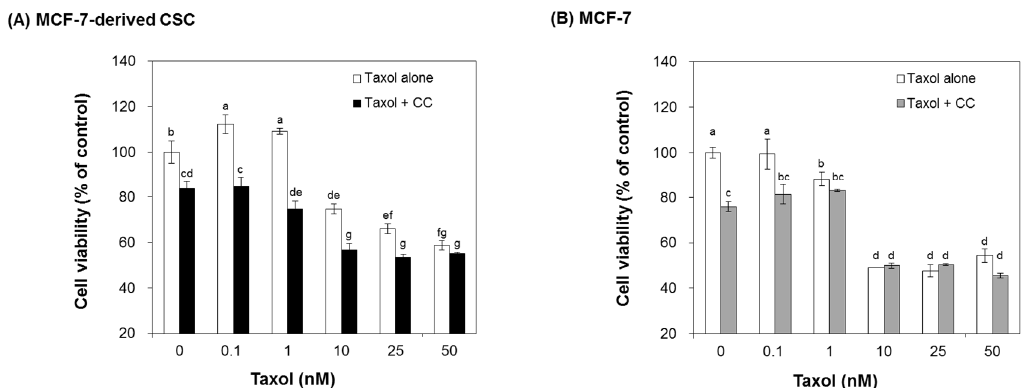
Figure 5. Chestnut leaf extract-treated CSCs were more susceptible to Taxol treatment than untreated CSCs. Both MCF-7-derived CSCs ( A ) and their parental cells ( B ) were treated with chestnut leaf extract in the presence of Taxol at various concentrations (0, 0.1, 1, 10, 25, and 50 nM). The CSCs exposed to the extract became more vulnerable to Taxol at ≥ 1 nM, compared to the cells that were not exposed to the extract. CC, Castanea crenata leaf extract, 50 µ g/mL. N = 3; error bars, mean ± SEM. Values not sharing common letter on bar indicate statistically significant difference from each other ( p < 0.05).